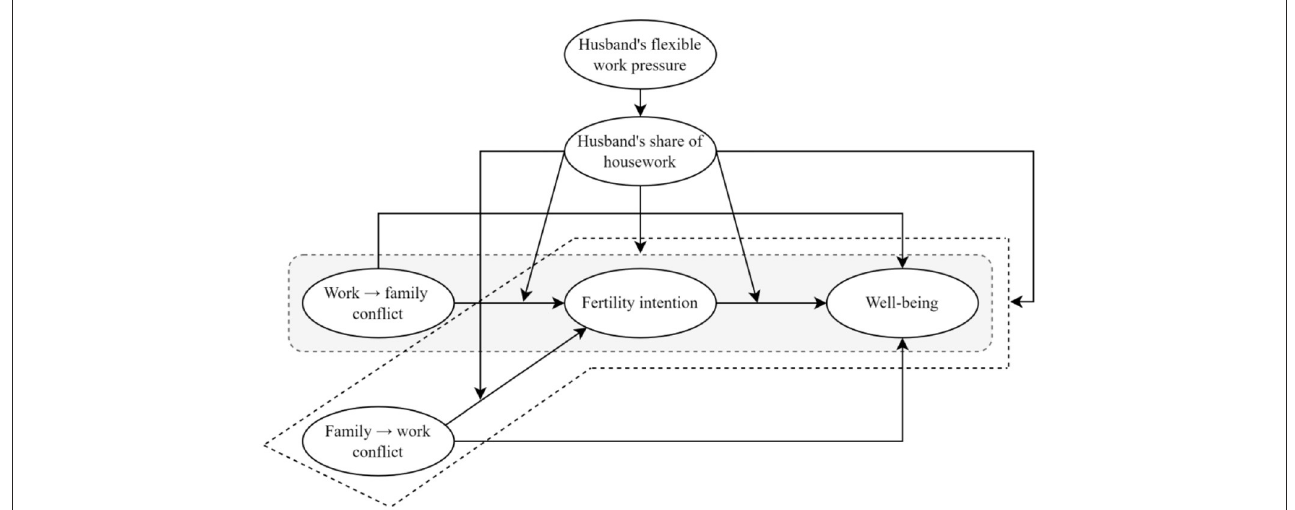
FIGURE1 Hypothetical model.